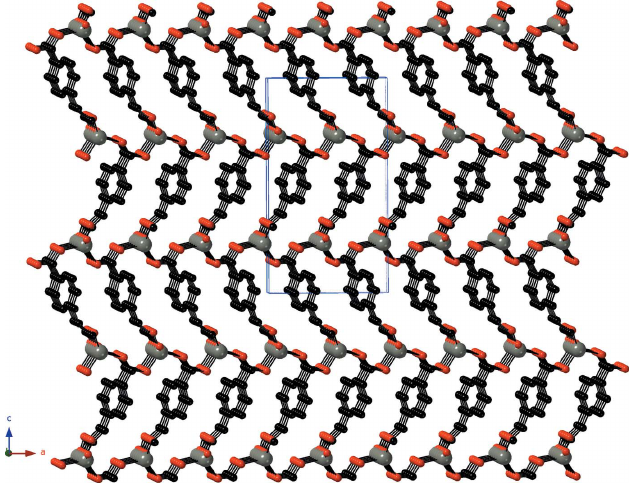
Figure 4 A schematic perspective of the 4,4-connected non-diamondoid 6 6 topology net in the title compound. The Zn atoms are shown in gray, and the centroids of the phenyl rings of the 4-cmb ligands are shown in teal.